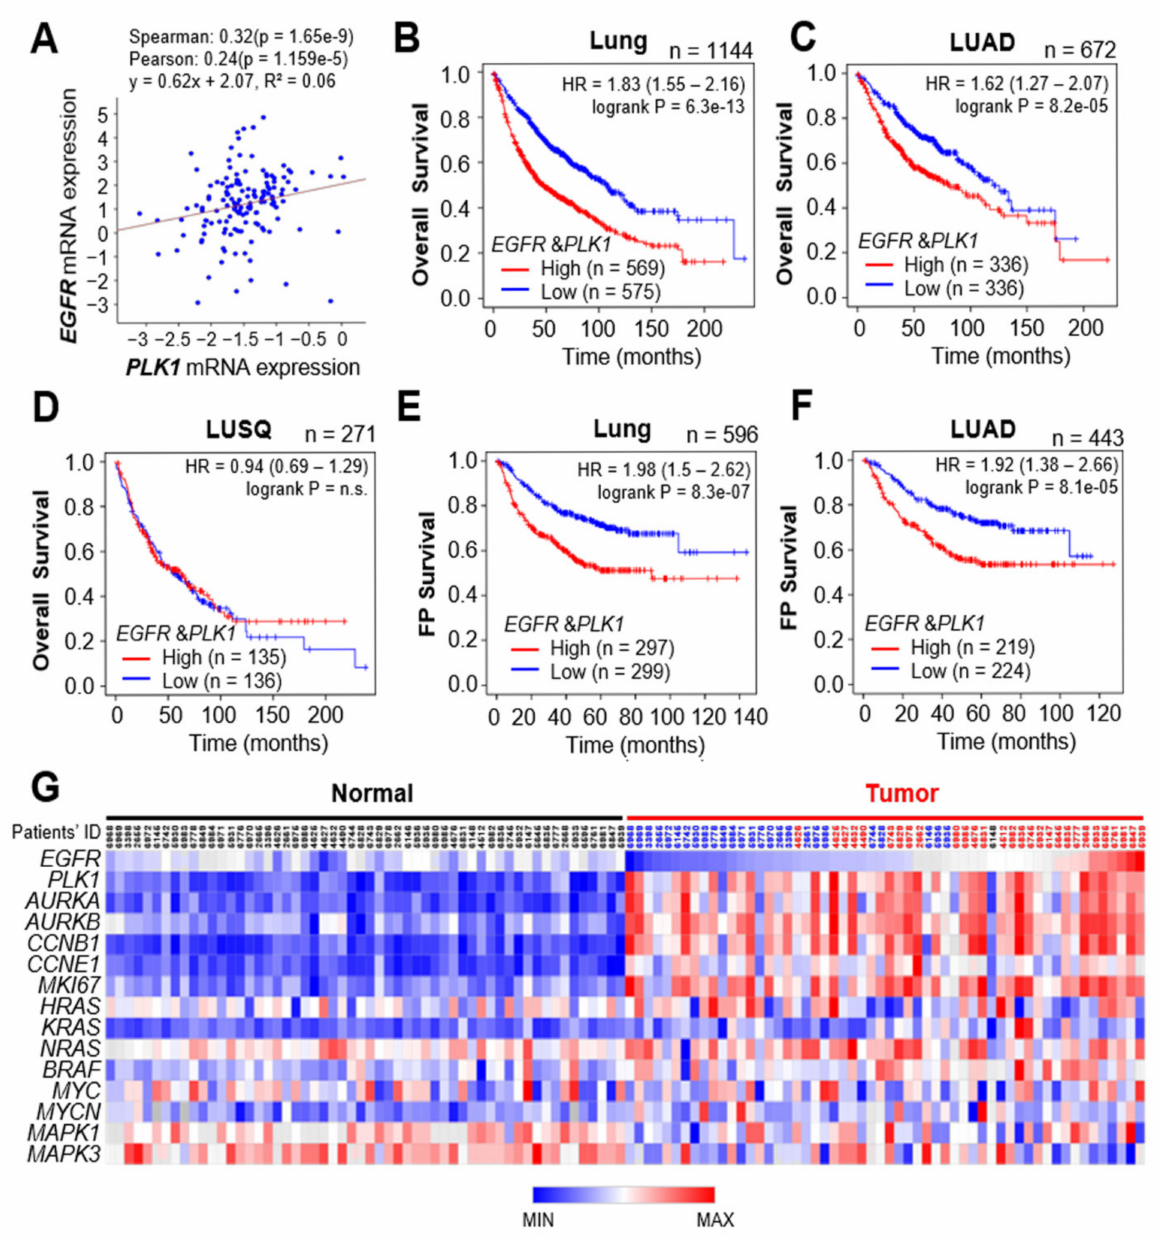
Figure 5. Clinical relevance of EGFR and PLK1 in LUAD cancer patients. ( A ) The relationship between the levels of EGFR and PLK1 in LUAD cancer patients based on Pearson’s and Spearman’s correlation analyses from cBioPortal. ( B – F ) Kaplan–Meier plots representing the probability of cumulative overall survival (OS) in ( B ) lung cancer patients, ( C ) LUAD, or ( D ) LUSQ stratified according to the expression status of PLK1 and EGFR . The probability of first progression (FP) survival in ( E ) lung cancer patients or ( F ) LUAD stratified according to the expression status of PLK1 and EGFR . The log-rank P -value reflects the significance of the correlation between survival rates and the expression levels of PLK1 and EGFR . HR, hazard ratio. ( G ) A heatmap was generated from Morpheus, showing the correlated expression levels of EGFR and PLK1 genes in normal (Normal) and tumor (Tumor) tissues of LUAD patients. Red color of patients’ ID in tumor tissues indicates that the expression of EGFR is higher in tumor tissue than that in normal tissue. Blue color, lower expression; Black color, the same